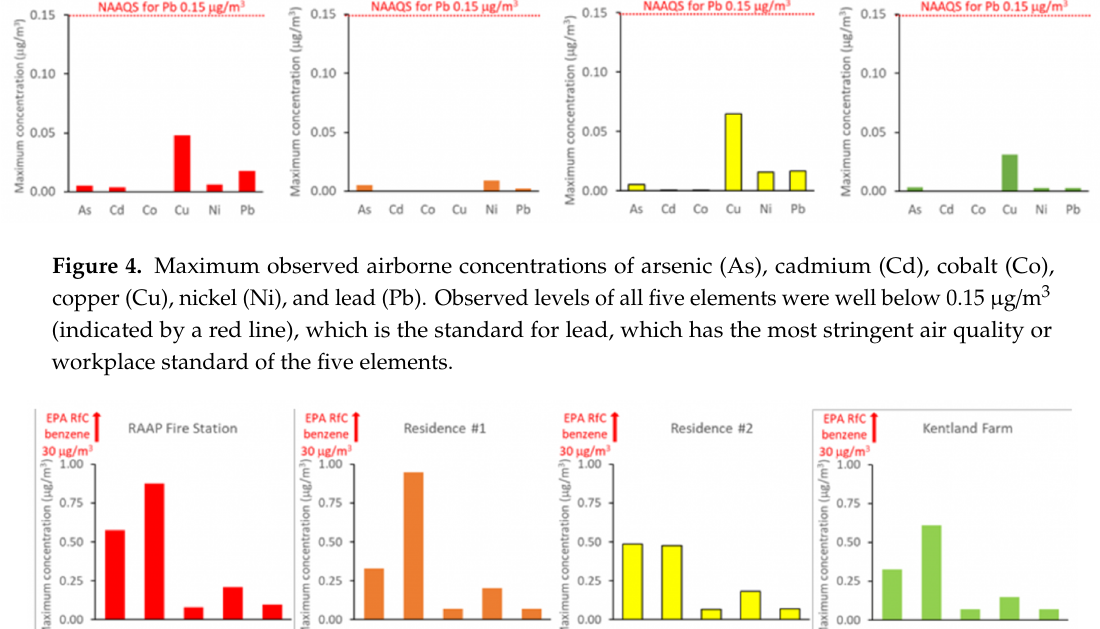
Figure 5. Maximum observed airborne concentrations of benzene (B), toluene (T), ethylbenzene (E), meta- and para-xylene (m,p-X), and ortho-xylene (o-X). Observed levels of all five volatile organic compounds were well below 30 μg/m 3 (indicated by an arrow on each graph that points off the chart range), which is the standard for benzene, the most stringent Reference Concentration (RfC), as set by the Environmental Protection Agency (EPA), of the five volatile organic compounds (VOCs).